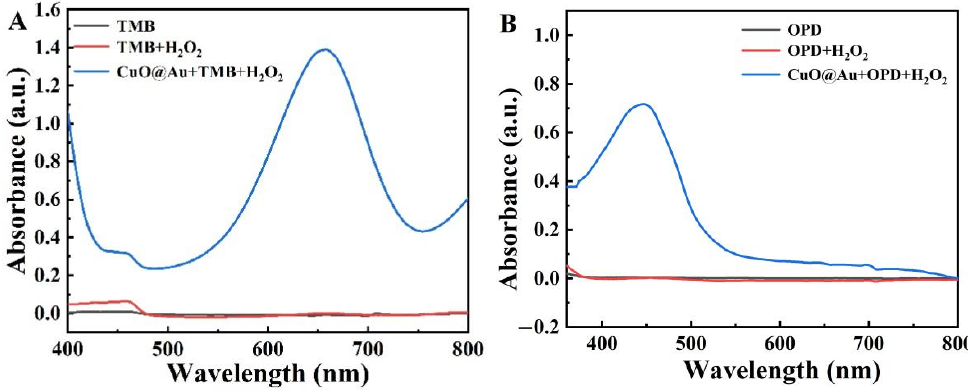
Figure 1. ( A ) FT-IR spectra for (a) histamine dihydrochloride, (b) tryptamine, (c) NIP, (d) MIP before elution, and (e) MIP after elution; ( B ) Adsorption isotherms for histamine on the MIP and NIP; ( C ) Adsorption isotherms for tryptamine on the MIP and NIP.